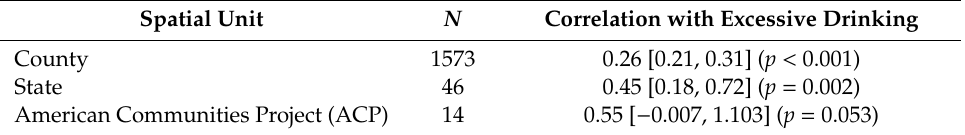
Table 1. Correlations between drunk tweet frequency and excess drinking at the county, state, and American Communities Project levels. Reported Pearson’s r with 95% confidence intervals in square